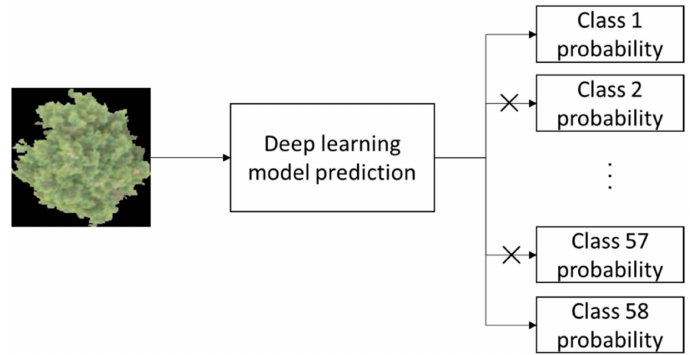
Figure 4. Image of inventory tuning.